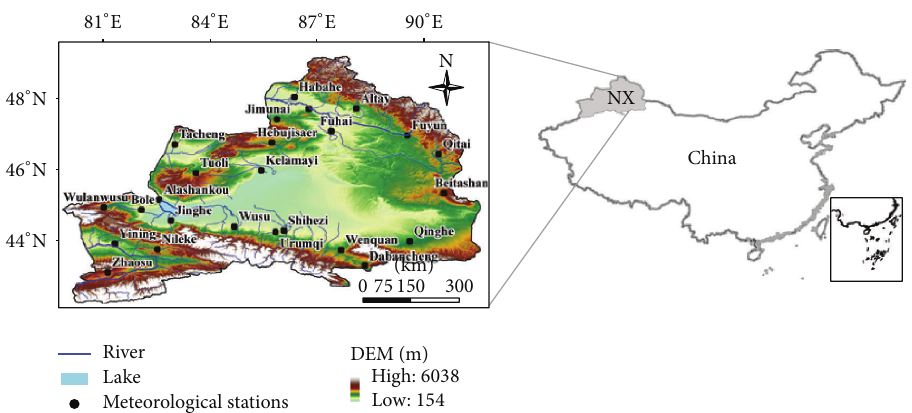
Figure 1: Geographical location of North Xinjiang,